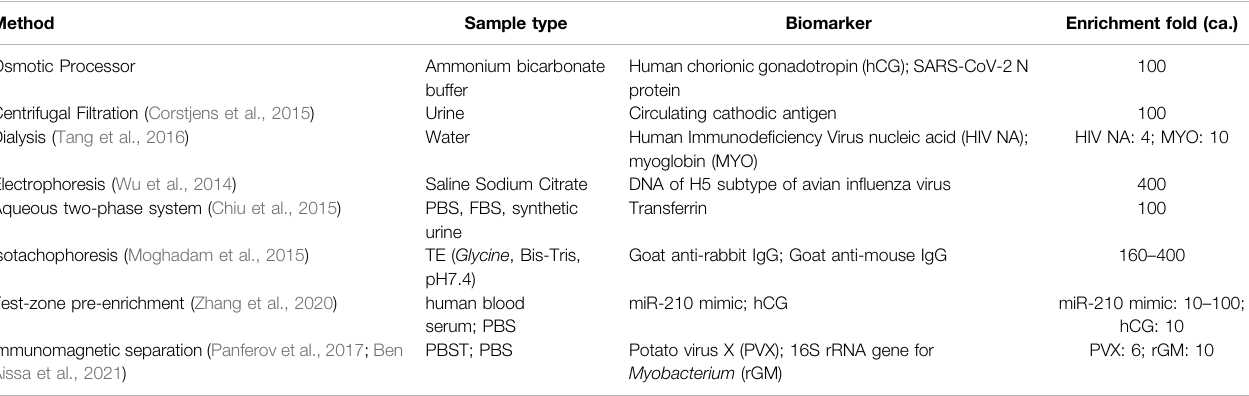
TABLE 2 | Analyte enrichment by various concentration